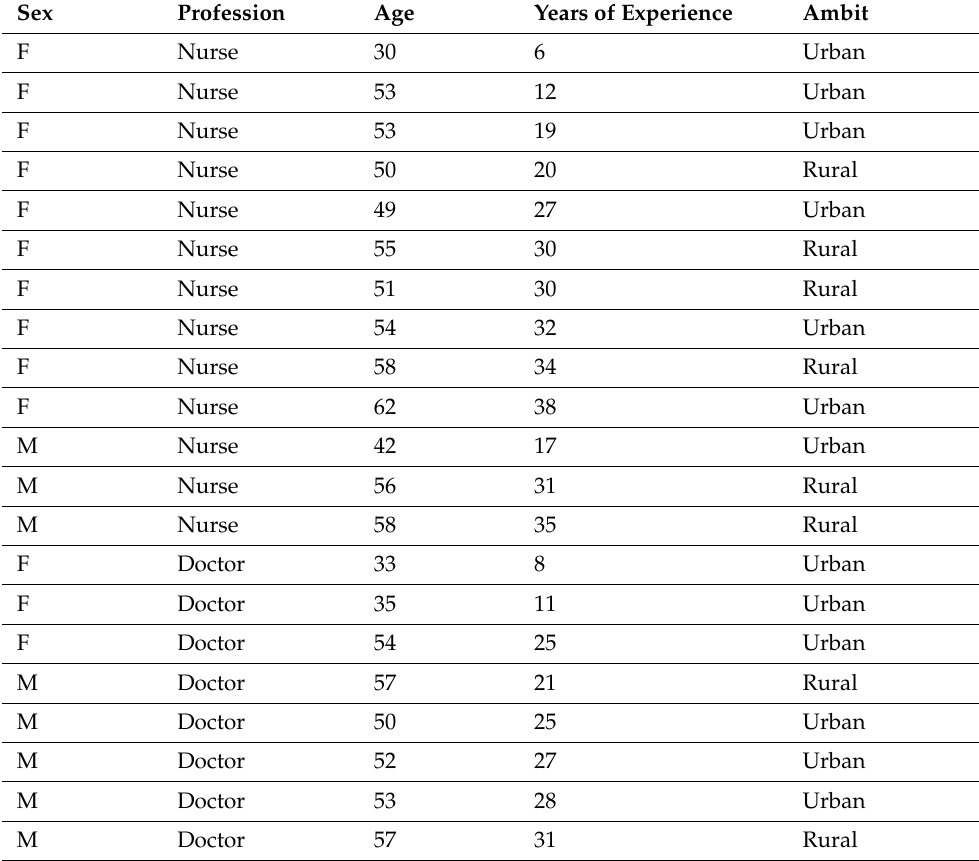
Table 1. Characteristics of